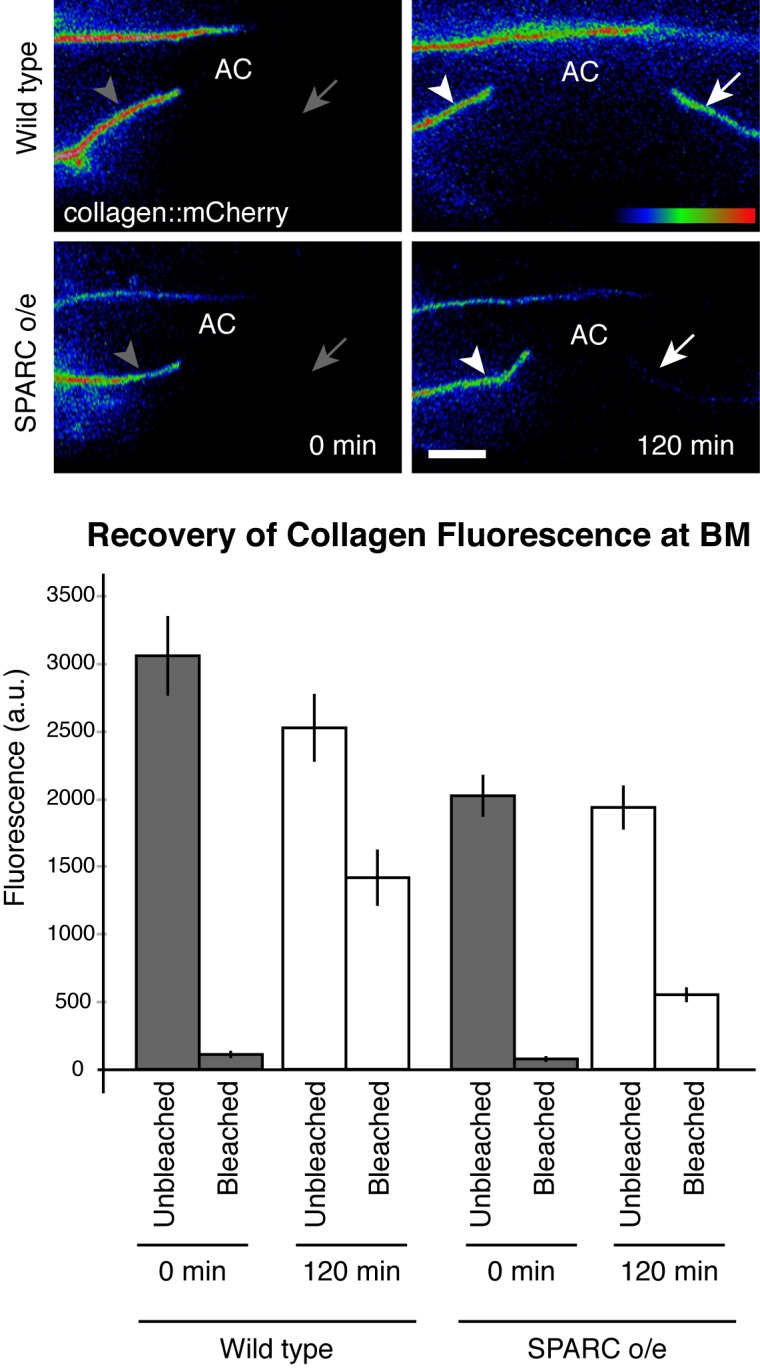
SPARC overexpression slows type IV collagen recovery in the BM.Half of the uterine tissue was photobleached by exposing collagen::mCherry within this region to 561 nm light for two minutes (0 min recovery, left; arrow denotes region of bleach, arrowhead denotes unbleached control region). Collagen::mCherry fluorescence recovery was assessed two hours later (120 min, right). Average collagen::mCherry fluorescence levels for the control and bleached regions at 0 min and 120 min is graphed below (error bars denote SEM). An average of 44±4% of the total collagen recovered in wild type and 25±3% of collagen in worms overexpressing SPARC (n≥10 for each condition, p<0.005 by two-tailed unpaired Student’s t-test). Scale bar denotes 5 μm.